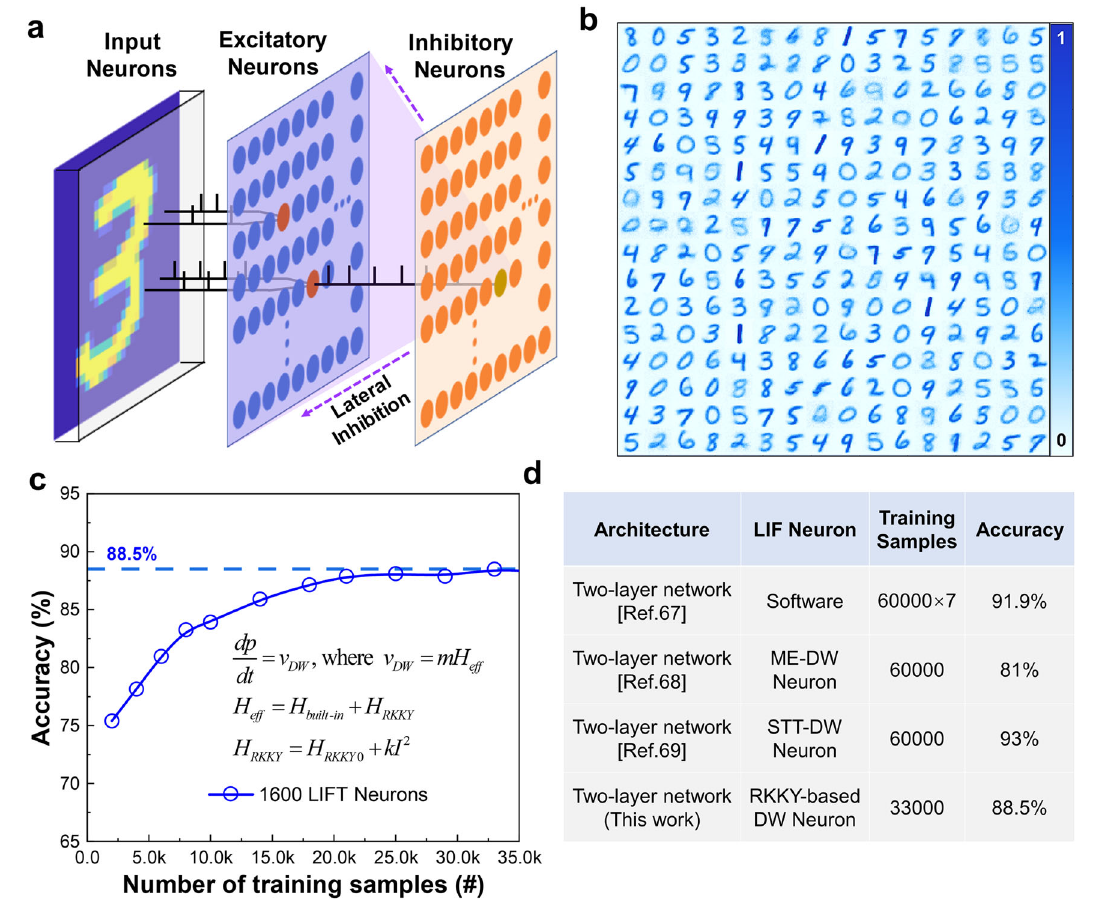
Fig. 6 | LIFT-SNN implementation. a LIFT-SNN topology structure. b Weight matrixofthe fi rst256excitatoryneuronsaftertraining. c MNISTdigitalhandwritten patterns recognition accuracy with 1600 excitation neurons under different